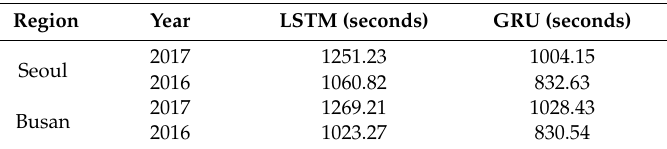
Table 4. Performance of LSTM vs. GRU hourly data.